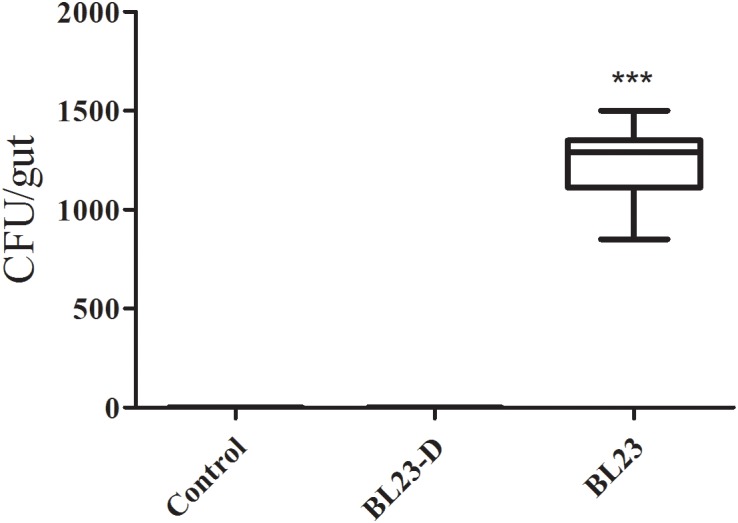
Retention of L. casei BL23 in the intestine of zebrafish juveniles. The data are shown as mean ± SEM (n = 8). Data were analyzed using ANOVA test followed by Bonferroni analysis. P-value of ≤0.05 is considered significant difference. Trible asterisk indicate P < 0.001.